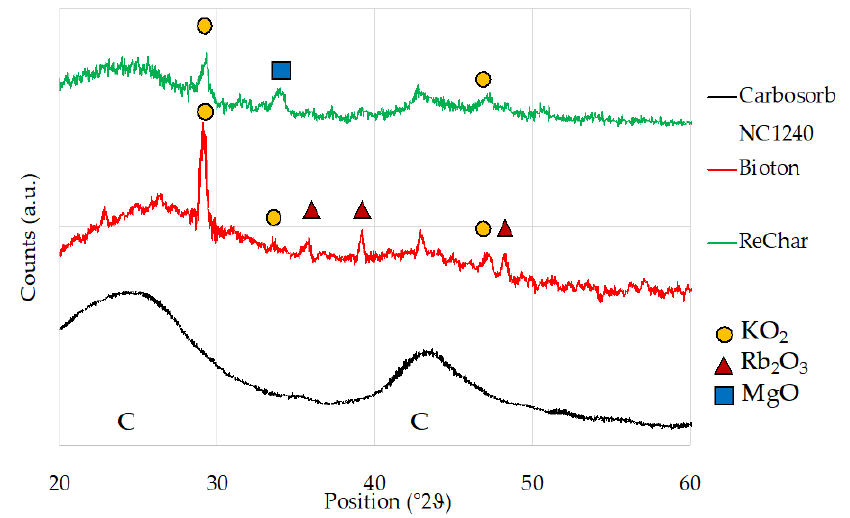
Figure 9. Comparison of XRD spectra of CARBOSORB NC 1240 ® , AMBIOTON ® , and RE-CHAR ® .